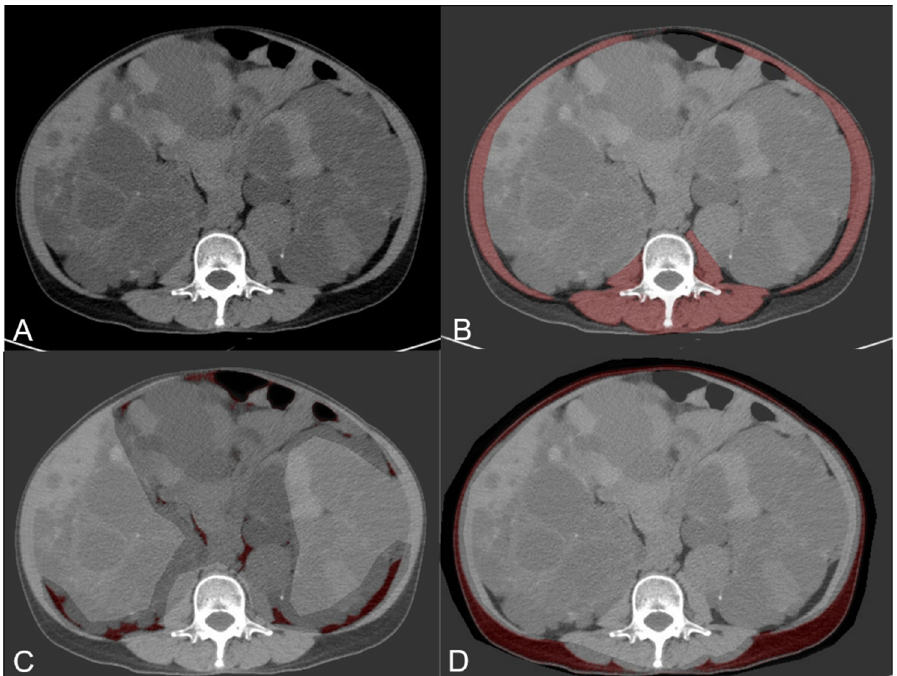
Figure 3. The nonenhanced CT image ( A ) at the L3 level was analyzed to determine the TAM ( B ), VAT ( C ), and SAT ( D ) area by using ImageJ. CT: computed tomography, TAM: total abdominal muscle, VAT: visceral adipose tissue, SAT: subcutaneous adipose tissue.